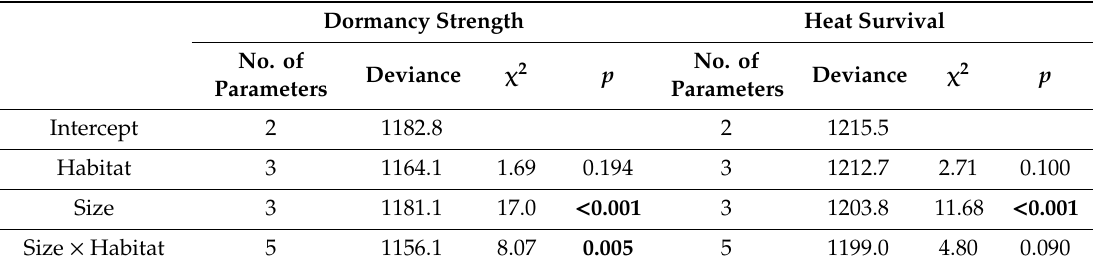
Table 2. Results of likelihood ratio tests (LRTs) showing the e ff ects of seed size, habitat type and their interactions on dormancy strength and heat survival of Cistus salviifolius . All models included population as random factor. Significant p -values ( < 0.05) are highlighted in